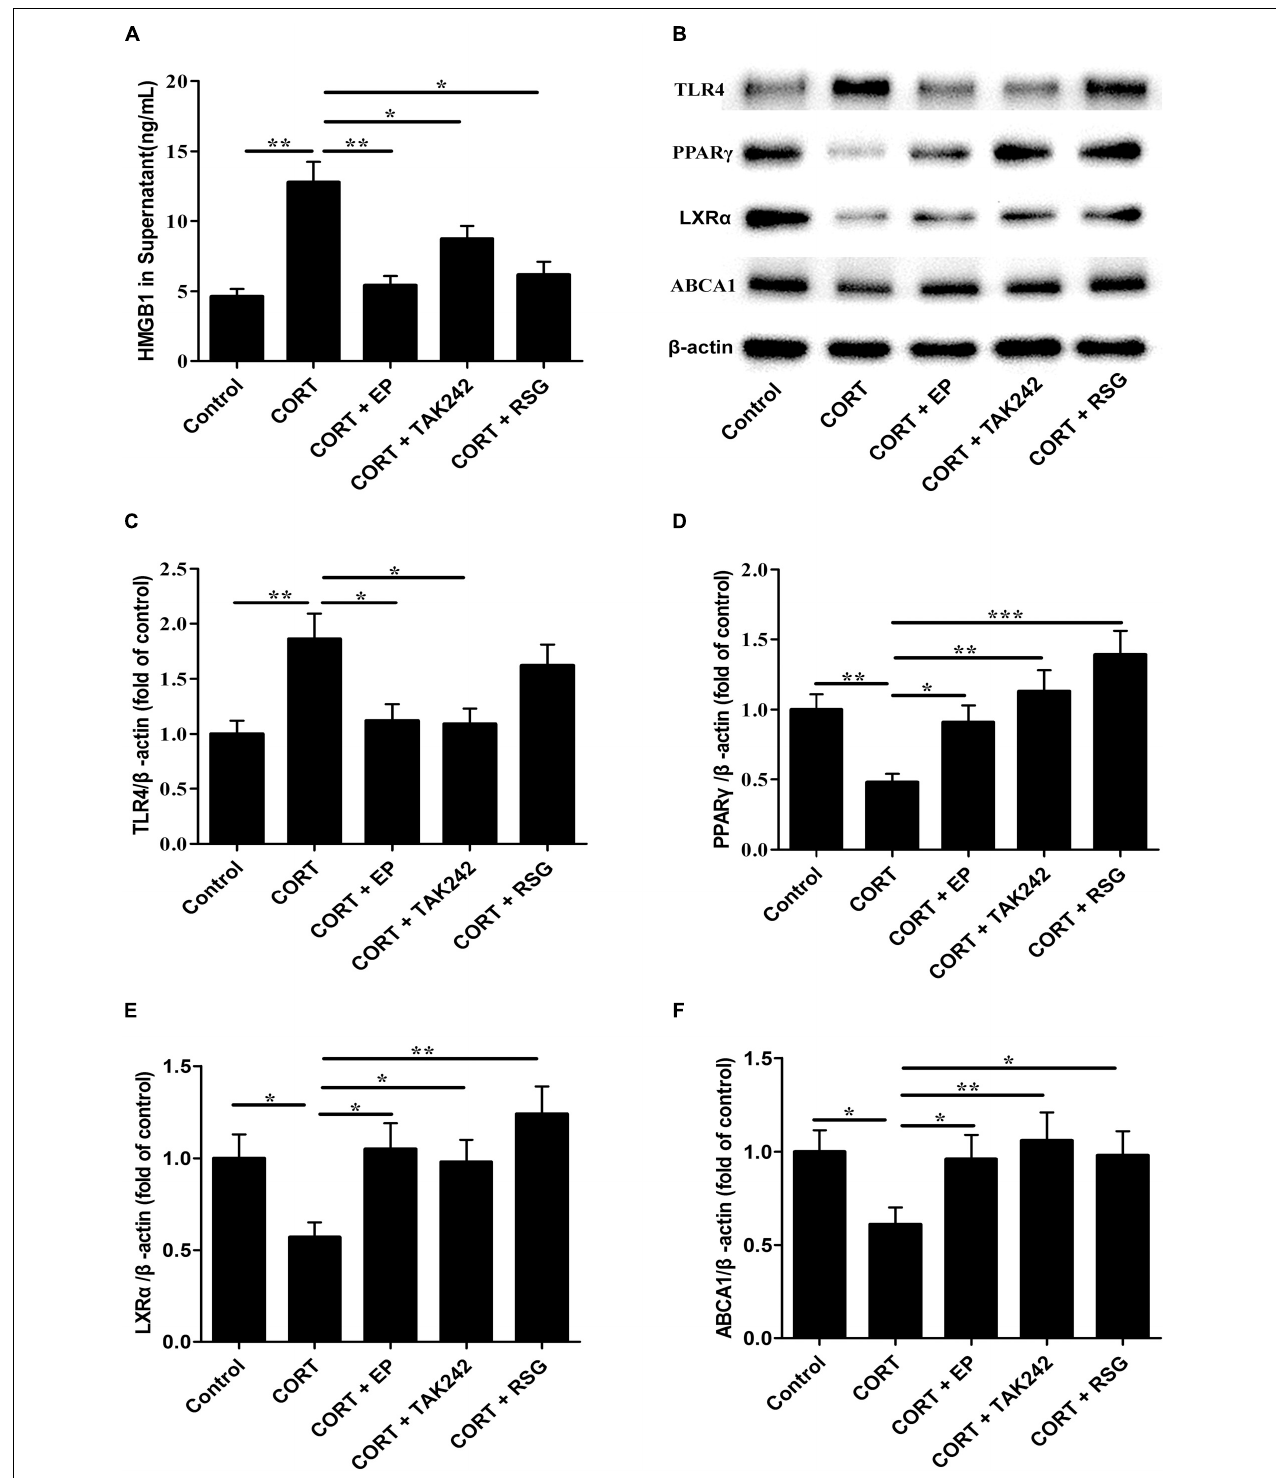
FIGURE 8 | Effect of EP, TAK-242, and RSG treatment on high level CORT-induced HMGB1 release, and TLR4, PPAR γ , LXR α , and ABCA1 protein expression in Raw 264.7 macrophage. Raw 264.7 macrophage cells were cultured oxLDL (20 µ g/mL) with or without EP (5 mM), TAK-242 (1 µ M), and RSG (10 µ M), in present or absence of 5 µ M of CORT for 36 h. (A) HMGB1 release of HMGB1 in supernatant was analyzed by ELISA. (B) Representative Western blots of TLR4 (95 kDa), PPAR γ (57 kDa), LXR α (50 kDa), and ABCA1 (254 kDa). (C–F) Quantification of TLR4, PPAR γ , LXR α , and ABCA1 protein levels by the NIH Image J software in the cultured macrophage cells. Data were expressed as mean ± SEM ( n = 3). ∗ P < 0.01, ∗∗ P < 0.01, ∗∗∗ P < 0.001.